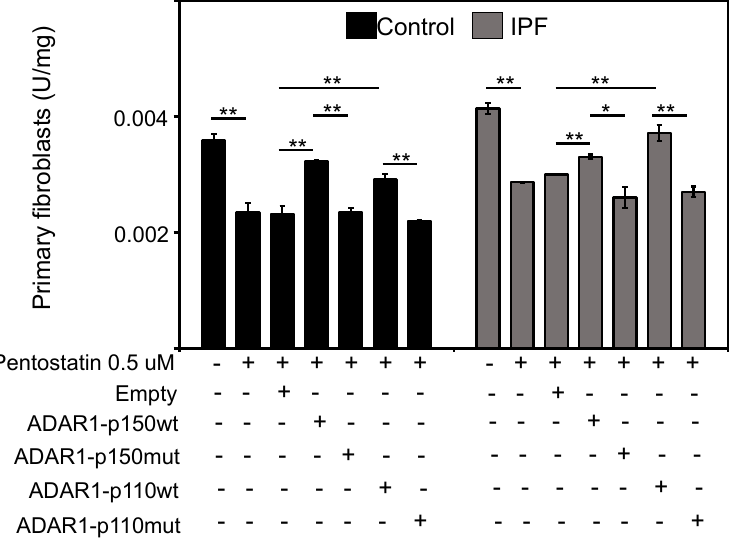
Figure 4. The specific catalytic activity of ADAR1 is increased in primary fibroblasts of IPF. Pento- statin, as a specific ADA inhibitor, significantly decreased the catalytic activity in control fibroblasts (** p = 0.0059) and IPF fibroblasts (** p = 0.0014). Over-expression of ADAR1-p150 wt (** p = 0.0058) and ADAR1-p110 wt (** p = 0.0018) significantly increased the catalytic activity of ADAR in control fibroblasts. Over-expression of ADAR1-p150 ( p = 0.8) and ADAR1-p110 mutant ( p = 0.72) did not induce significant changes in the catalytic activity in the control fibroblasts. ADAR1-p150 wt over- expression in IPF fibroblasts significantly increases its activity (** p = 0.0042) like the over-expression of ADAR1-p110 (** p = 0.0067). Over-expression of ADAR1 mutant plasmids does not modify the activity. ADAR1-p150 mutant ( p = 0.2) and ADAR1-p110 mutant ( p = 0.02).